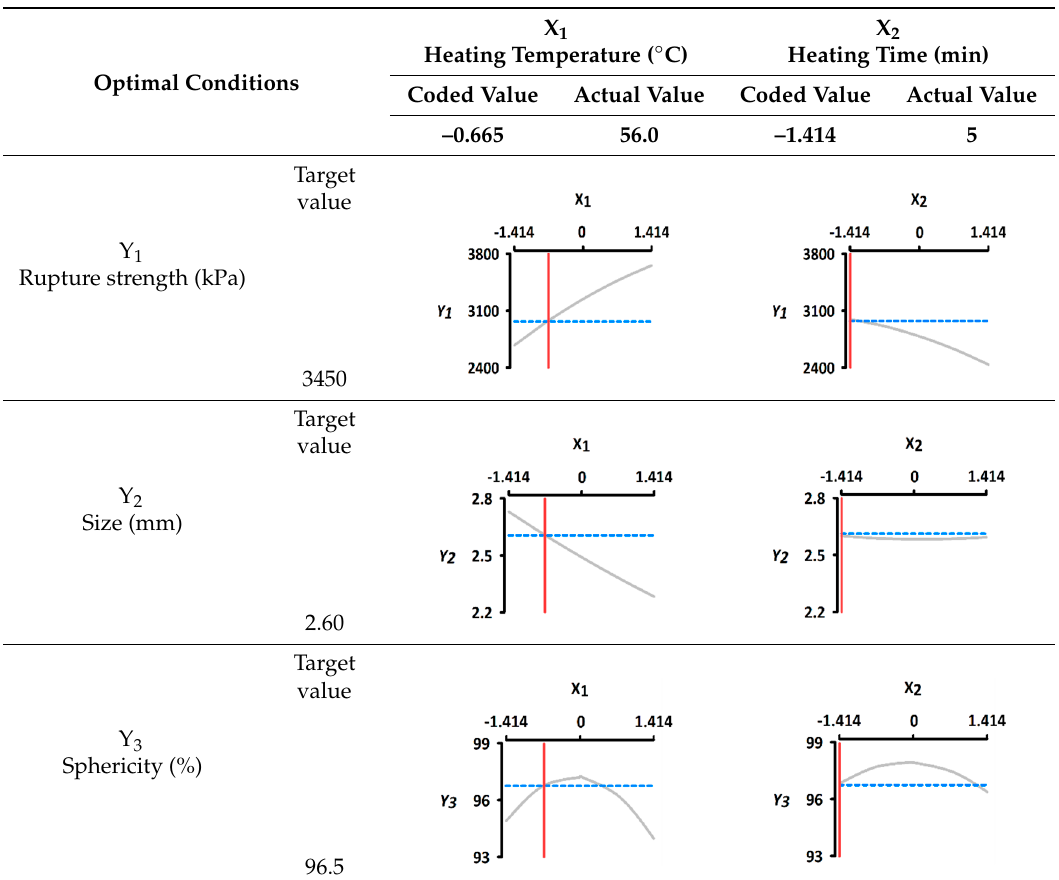
Table 9. Experimental and predicted results of verification under optimized conditions.